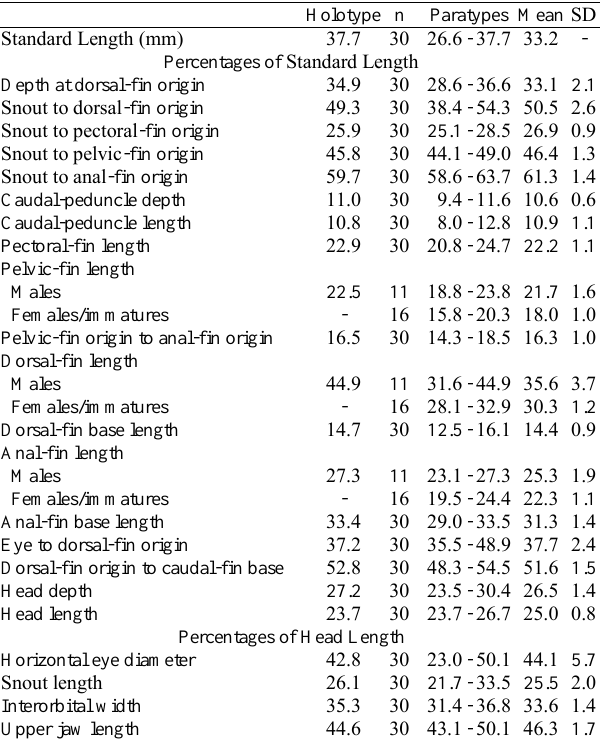
Table 1. Morphometrics of Hemigrammus ataktos , n = number of specimens, SD = Standard